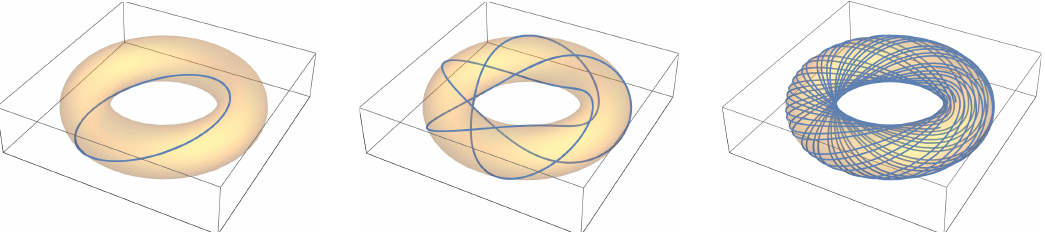
Figure 3: The guiding center paths of fig. 2 represented on tori embedded in a three- sphere S 3 (whose points satisfy x 2 + y 2 + u 2 + v 2 = cst). Through stereographic projection, one can think of this S 3 as (cid:82) 3 plus a point at infinity, so each of the three plots in this figure depicts one edge mode in what will, eventually, be the boundary of a Hall droplet. As in fig. 2, the anisotropy (7) is ∆ = 1, 5 / 3 and